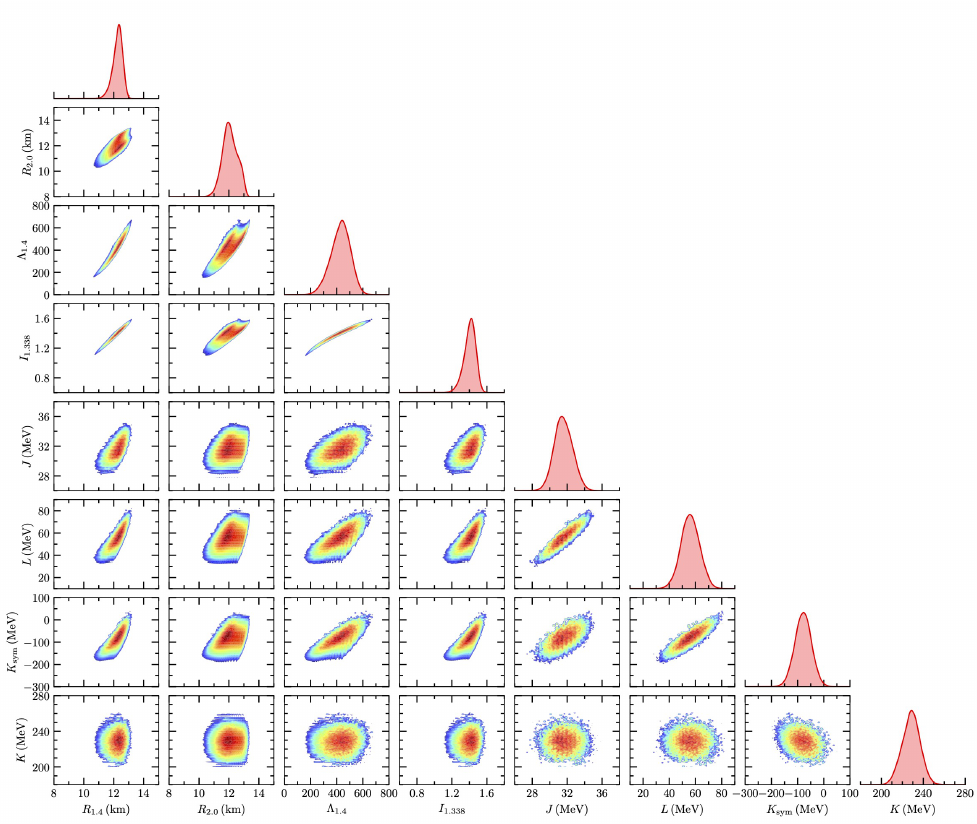
Figure 2. Correlations among neutron star properties and nuclear matter properties from the posterior probability distribution Equation (16) when the maximally-stiff high-density EOS extrapolation is prior . The colors in the 2D correlations represent the magnitude of the probability density, used for L increasing from blue to